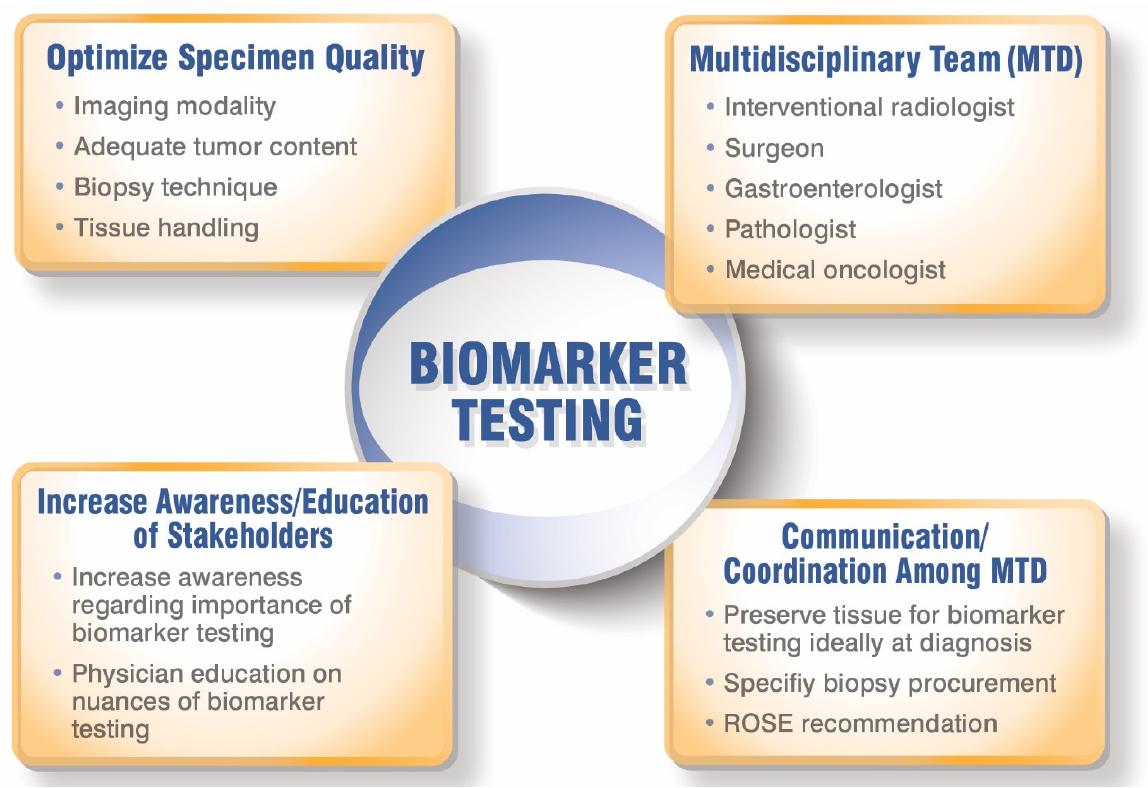
Figure 2. Optimizing biomarker testing for patients with iCCA.